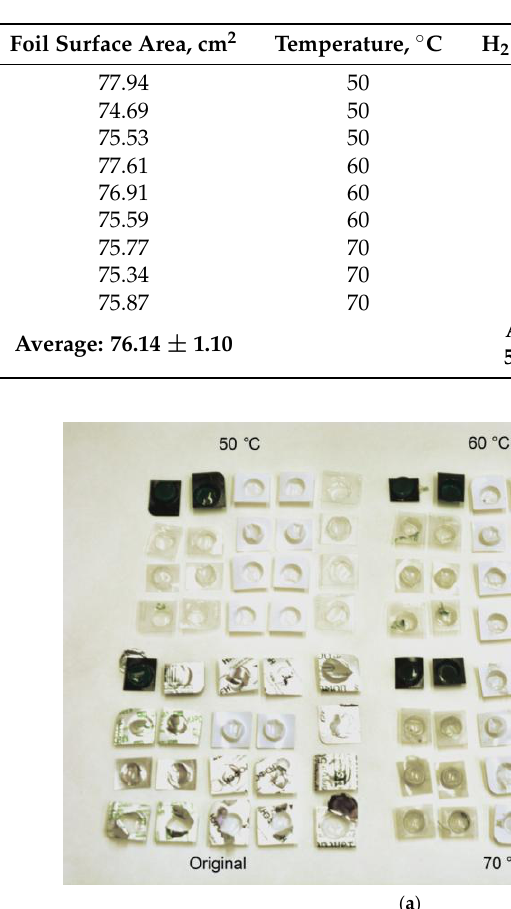
Figure 2. Kinetic curves for PVC–Al blisters under different temperatures. Table 1. Blister sample masses, foil surface areas, hydrogen yields, and maximum evolution rates.